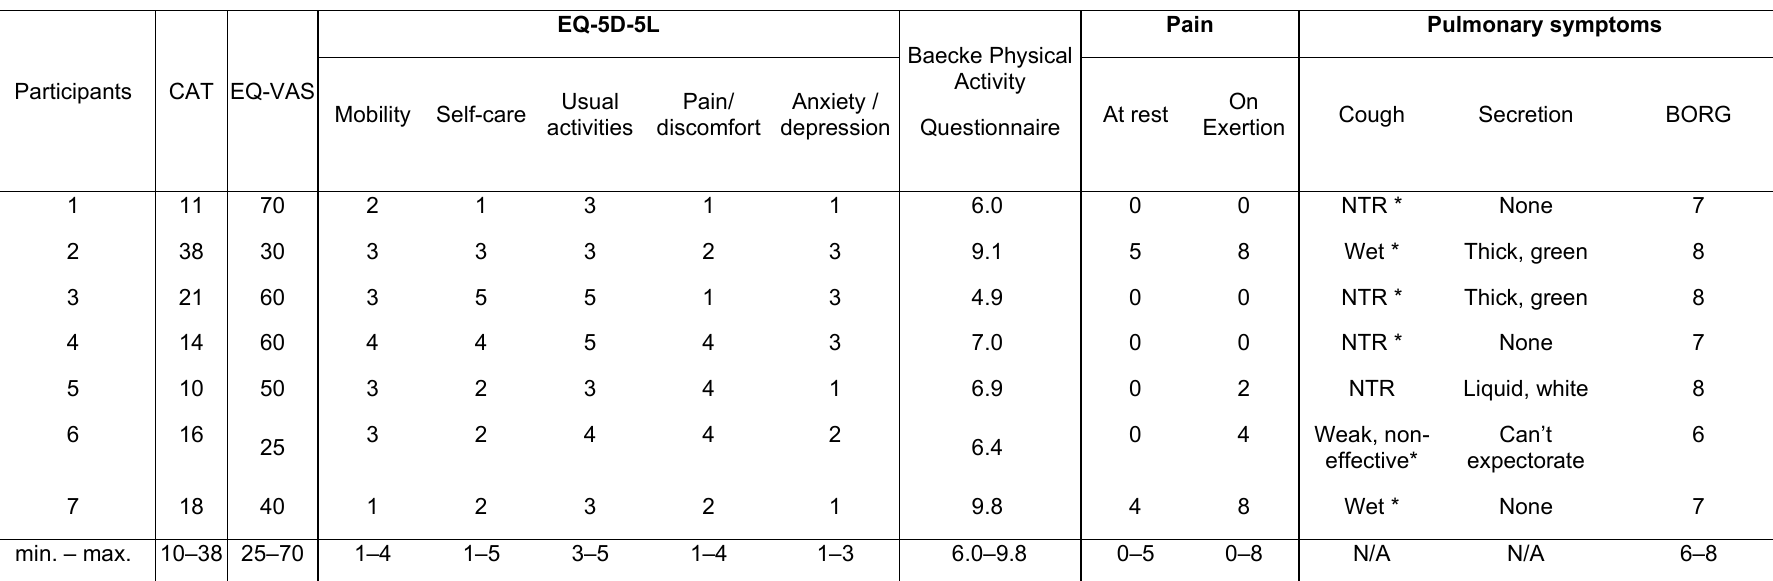
Table 3 Pulmonary and Functional Profiles before the Intervention